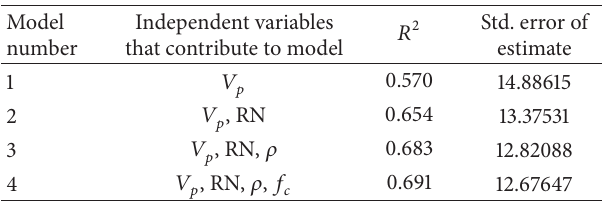
Table 2: Summary statistics for the five models of multivariable linear regression analysis.